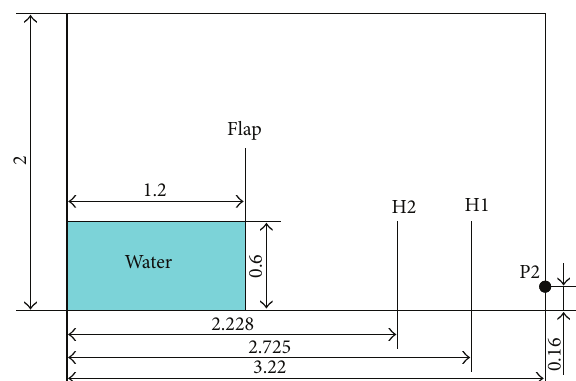
Figure 8: Problem definition and measurement points for water heights and pressure (in